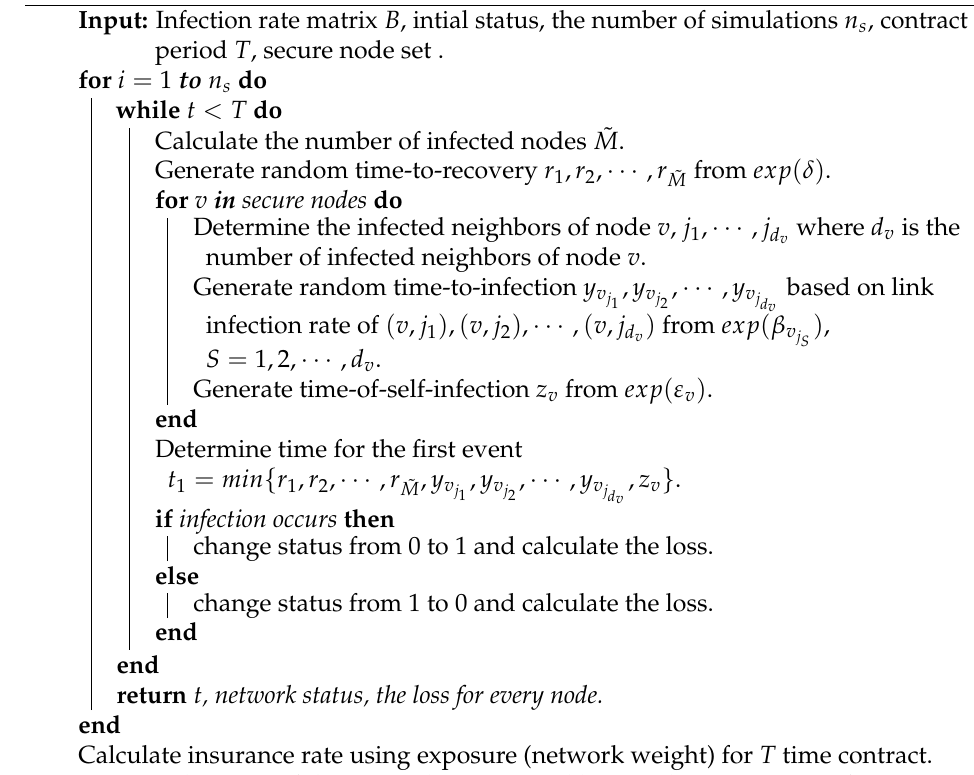
Algorithm 3: Simulation of cyber security risk with different infection